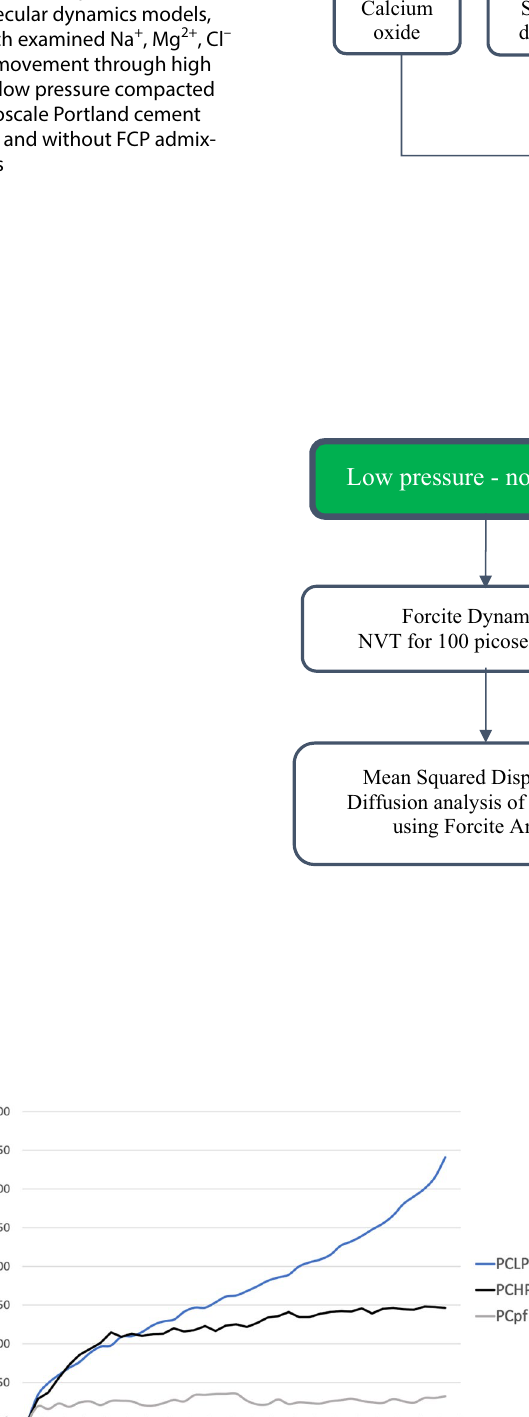
Fig. 15 Build process for the molecular dynamics models, which examined Na + , Mg 2+ , Cl – ion movement through high and low pressure compacted